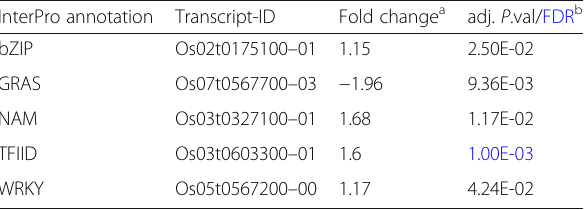
Table 2 The differentially expressed transcription factors encoded by the rice genes under the control of PIPs (Continued) InterPro annotation Transcript-ID